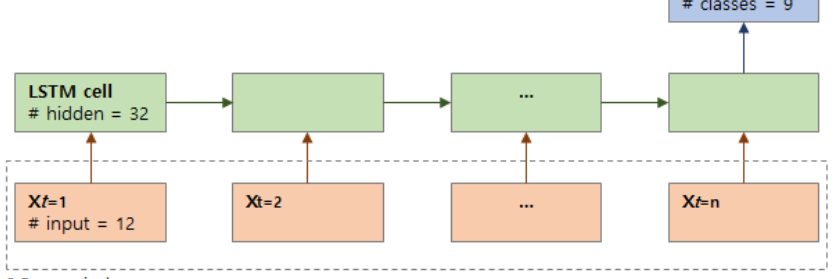
Figure 4. Many-to-one Long Short-Term Memory (LSTM) network architecture used for activity classification with nine classes. n stands for the number of samples included in a 2.5 s